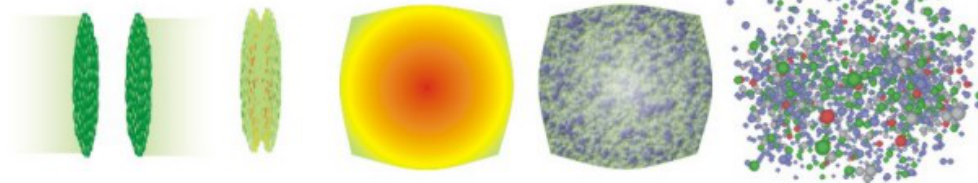
(cid:10) (cid:11) N part in Pb + Pb and